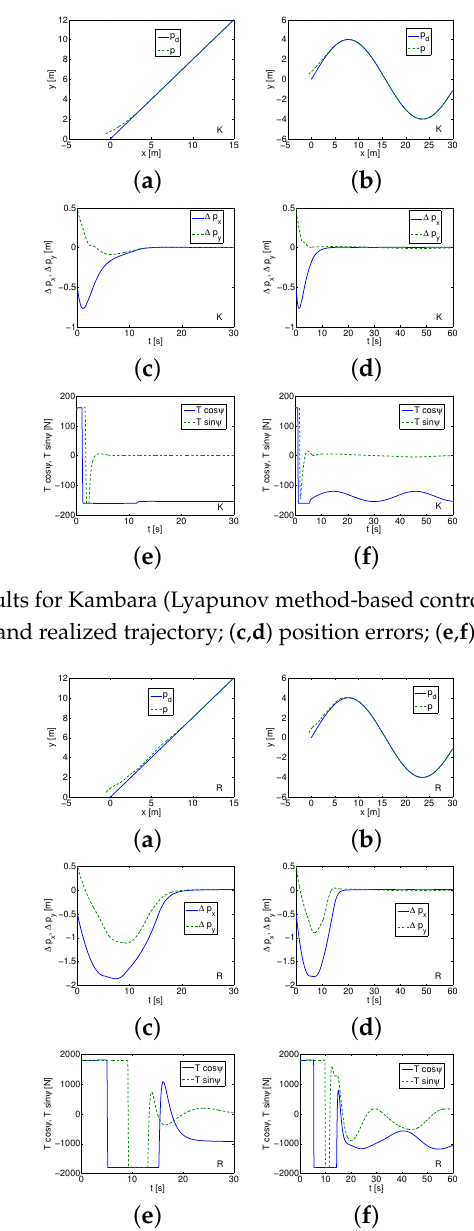
Figure 3. Simulation results for ROPOS (Lyapunov MBC)—linear and sine trajectory. ( a , b ) Desired and realized trajectory; ( c , d ) position errors; ( e , f ) applied